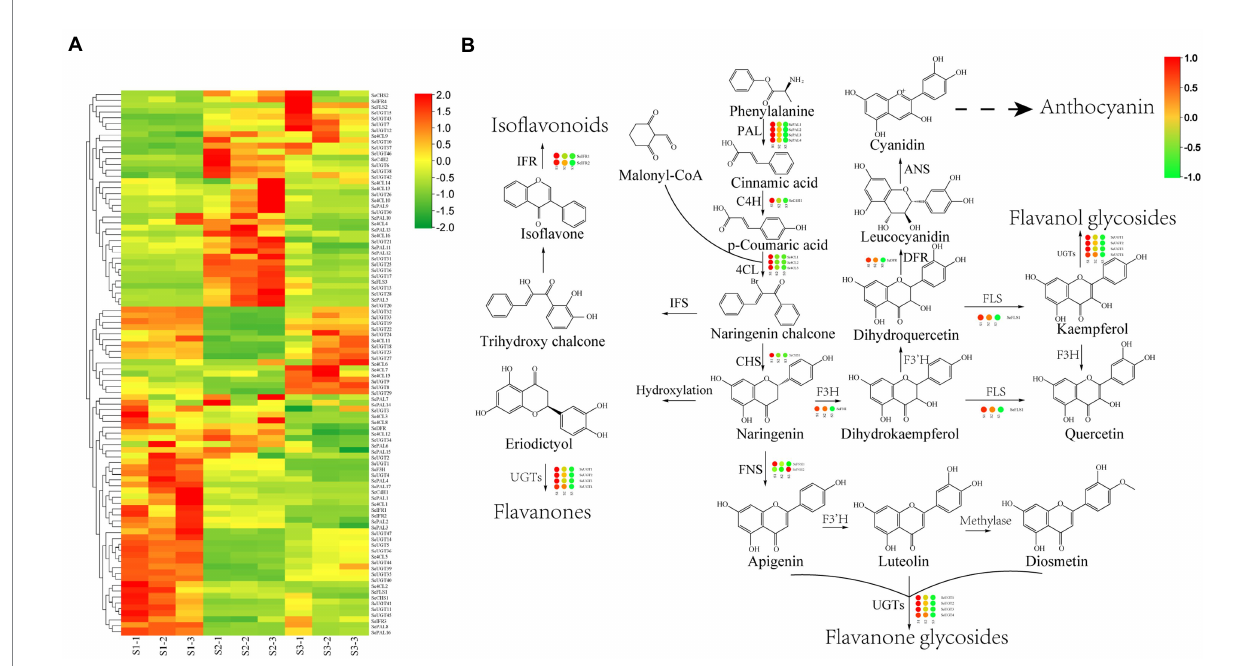
FIGURE 7 Identification of DEGs encoding the key enzymes associated with flavonoids synthesis . (A) Heatmap showing the expression of DEGs in chayote fruits at three different storage stages. (B) Expression profiles of DEGs involved in the flavonoid synthesis pathway. Upregulated (red) and downregulated (green) genes are indicated.